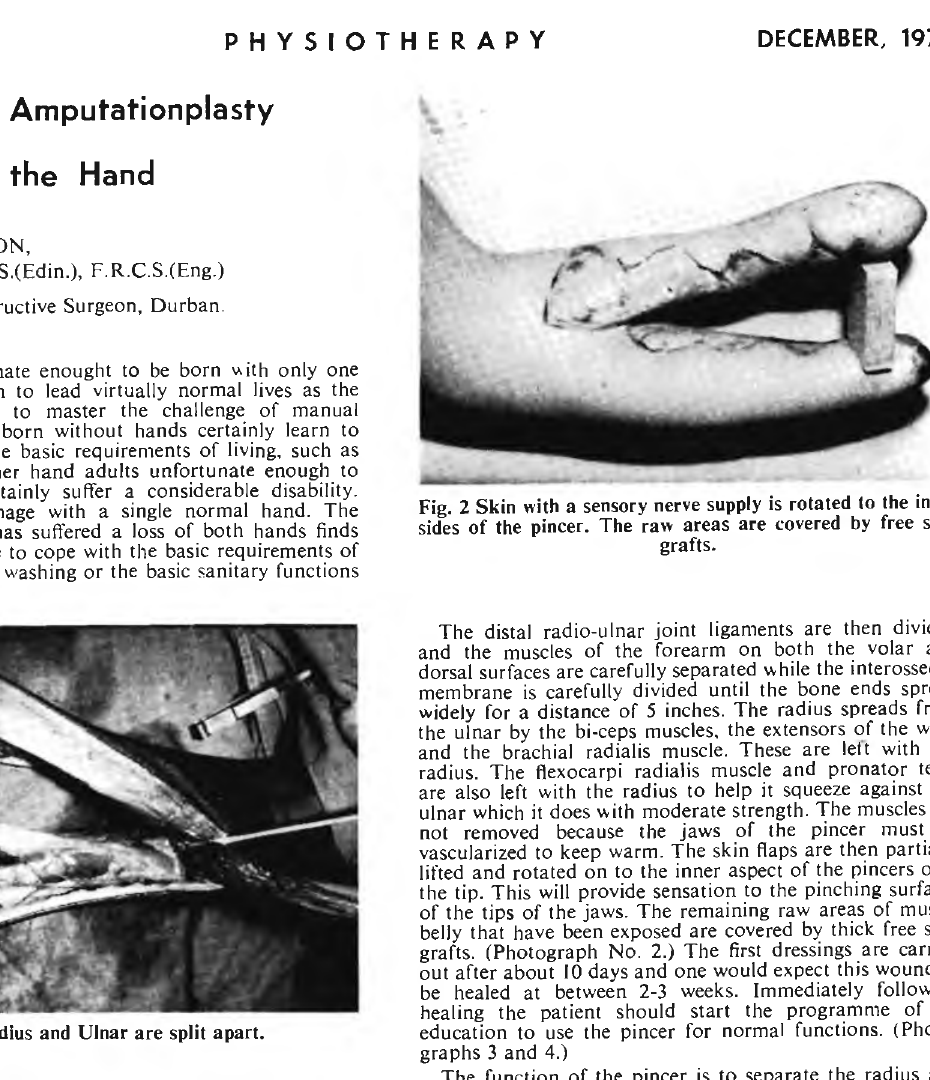
Fig. 1 Radius and Ulnar are split